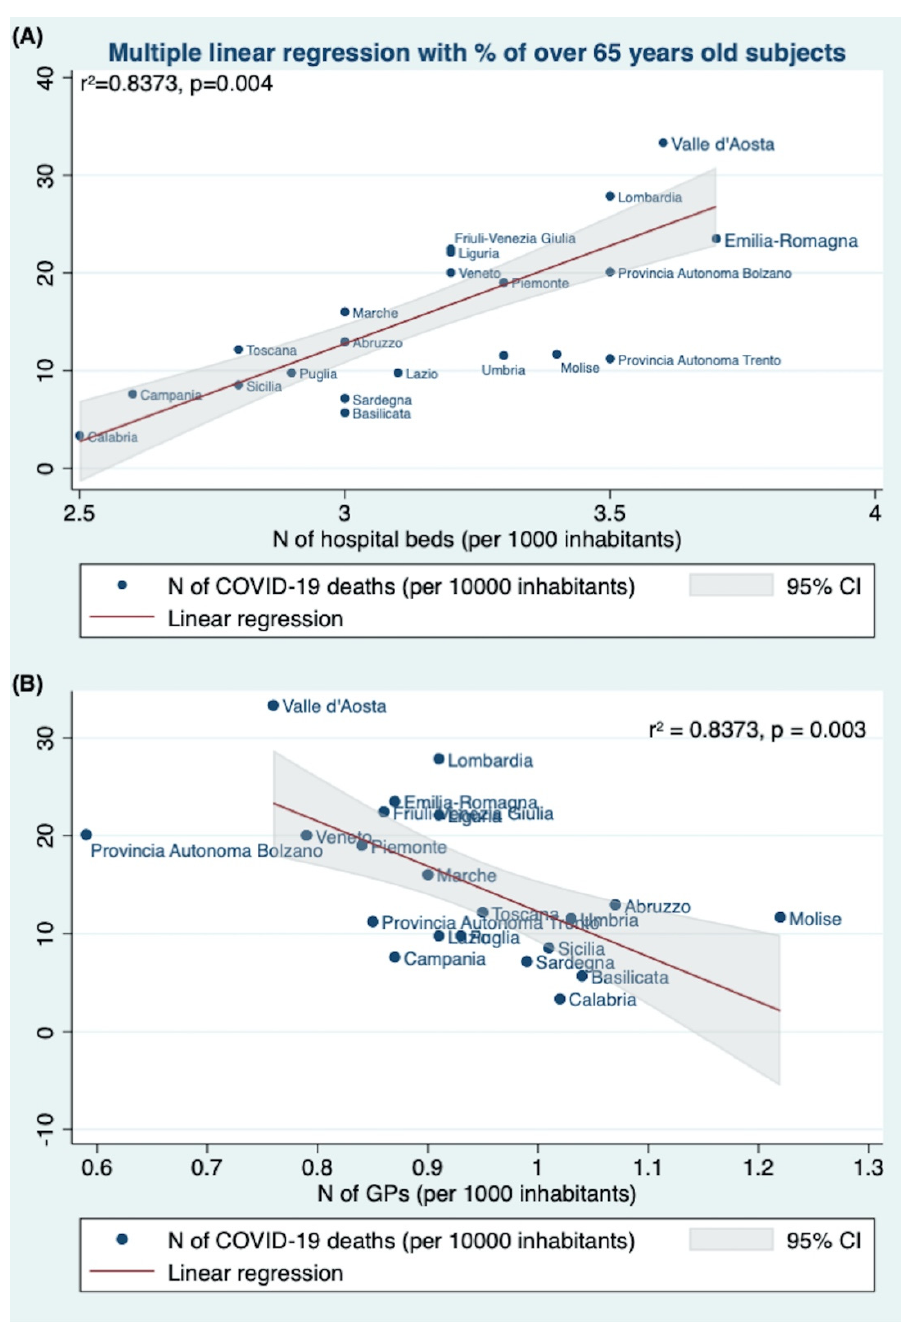
Figure 1. Multiple linear regression among the number of COVID-19 deaths (×10,000 inhabitants) and ( A ) the number of hospital beds (×1000 inhabitants), and ( B ) the number of GPs (×1000 inhabitants) per Italian region. In a multivariate linear regression analysis, introducing the number of COVID-19 deaths (per 100,000) as the dependent variable and the percentage of subjects ≥ 65 years old, the number of hospital beds (per 1000), the health expenditure per capita, the GPs per 1000, and the number of LTCF significantly as the independent variable, the number of hospital beds (per 1000) ( β = 14.8381, p = 0.004) and the number of GPs (per 1000 inhabitants) ( β = − 33.6430, p = 0.003) significantly predicted the number of COVID-19 deaths (×10,000 inhabitants). The Italian regions with a higher number of hospital beds (×1000 inhabitants) and a lower number of GPs showed a higher COVID-19 death rate. The line shows the linear regression value obtained by the multivariate analysis.